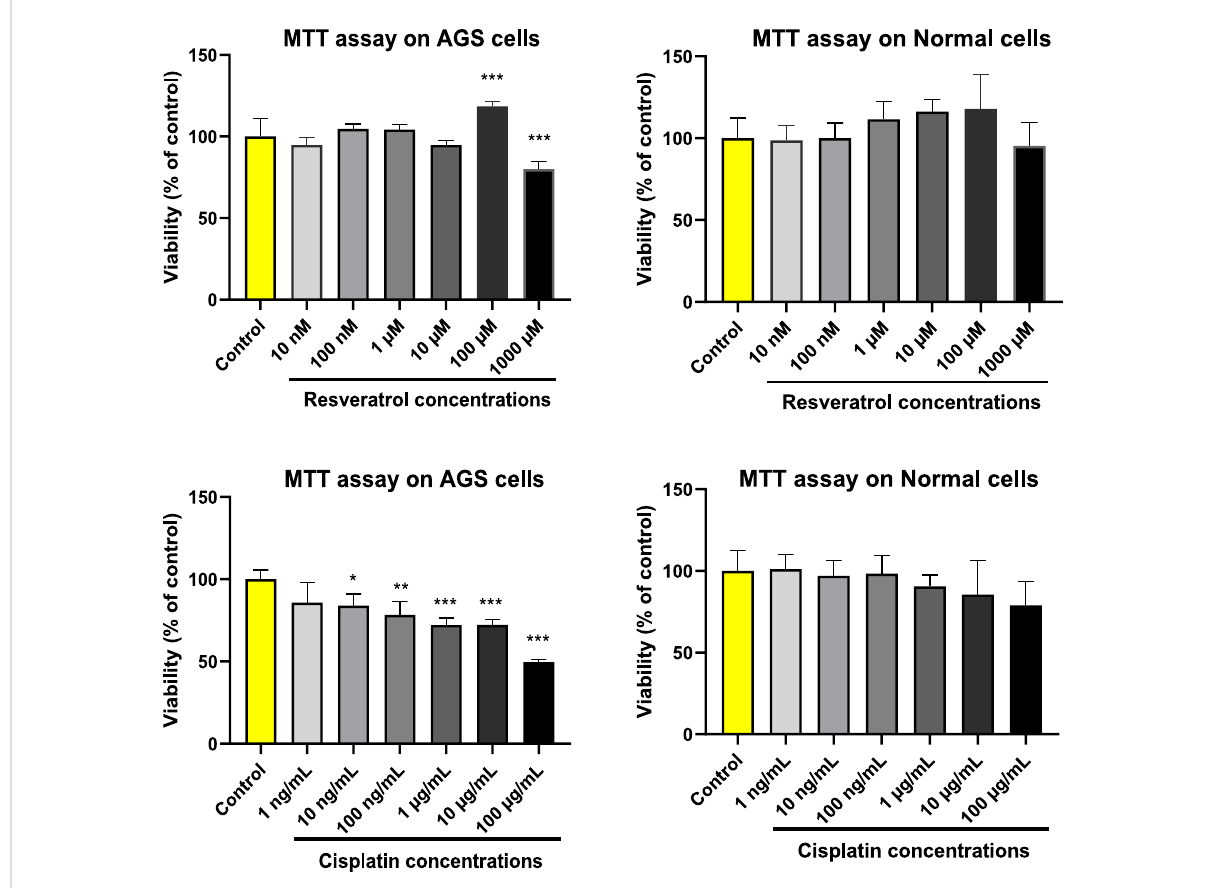
FIGURE 1 Cytotoxicity effects of different concentrations of resveratrol (RES) and cisplatin(CIS) on the viability of adenocarcinoma gastric cells (AGS) and normal HEK293 cell line. The results are expressed as mean ± SD performed on n = 6, with two independent replicates. *** ( p < 0.001), ** ( p < 0.01), and * ( p < 0.05) show a signi fi cant difference compared to the control